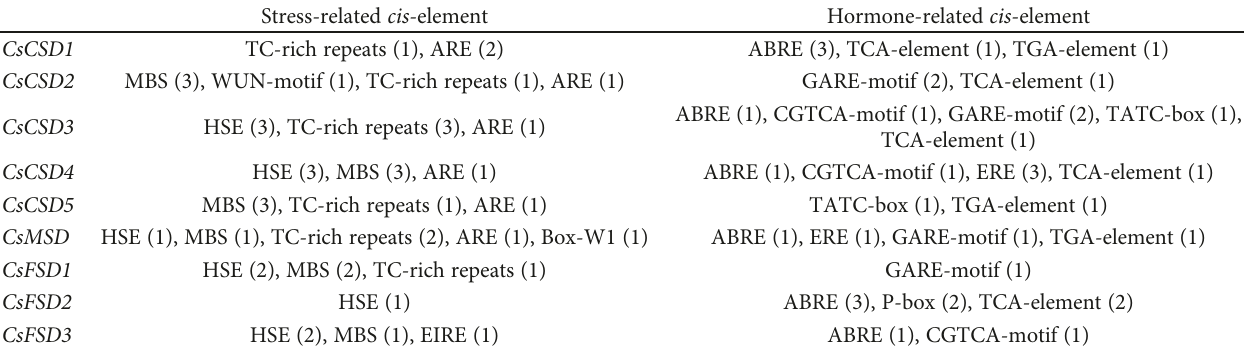
Table 2: Kinds and numbers of known stress-related and hormone-related cis -elements in the promoter regions of CsSOD genes. Stress-related cis -element